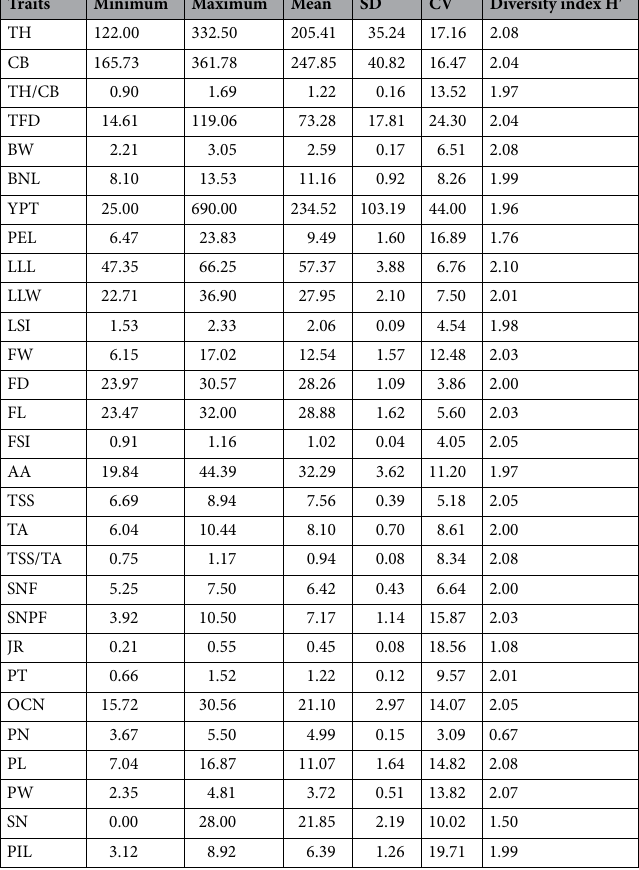
Table 3. Diversity analysis of quantitative traits.